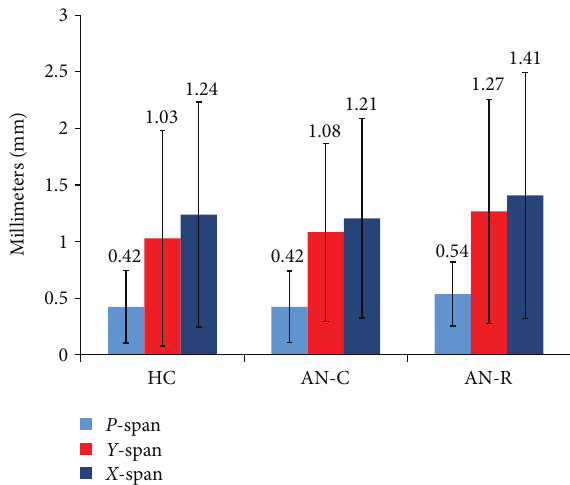
Figure 1: The main effect of group on 𝑃 -span, 𝑌 -span, and 𝑋 -span. 𝑃 -span scores reflect pupil dilation (in mm) after stimulus onset. 𝑌 - spanand 𝑋 -spanscoresreflectmovementhorizontallyandvertically (mm) from the central point of the picture. A significant main effect of group was found for all three measures ( 𝑝 < 0.05 ). Post hoc Bonferroni corrected 𝑡 -tests indicated this was driven by increased scores on all three measures in the AN-R compared to the AN-C and HC groups ( 𝑝 < 0.05 ). AN-C: acute Anorexia Nervosa group, AN-R: recovered Anorexia Nervosa group, and HC: healthy control